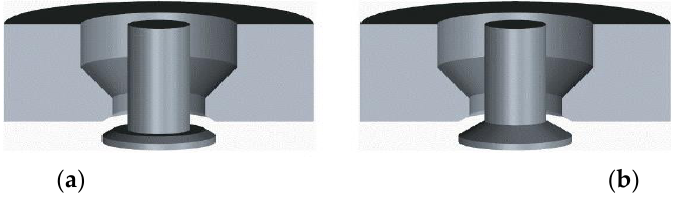
Figure 1. Push-open gas fuel injector with a flat and conical valve: ( a ) Type A—Flat valve; ( b ) Type B—Conical valve.